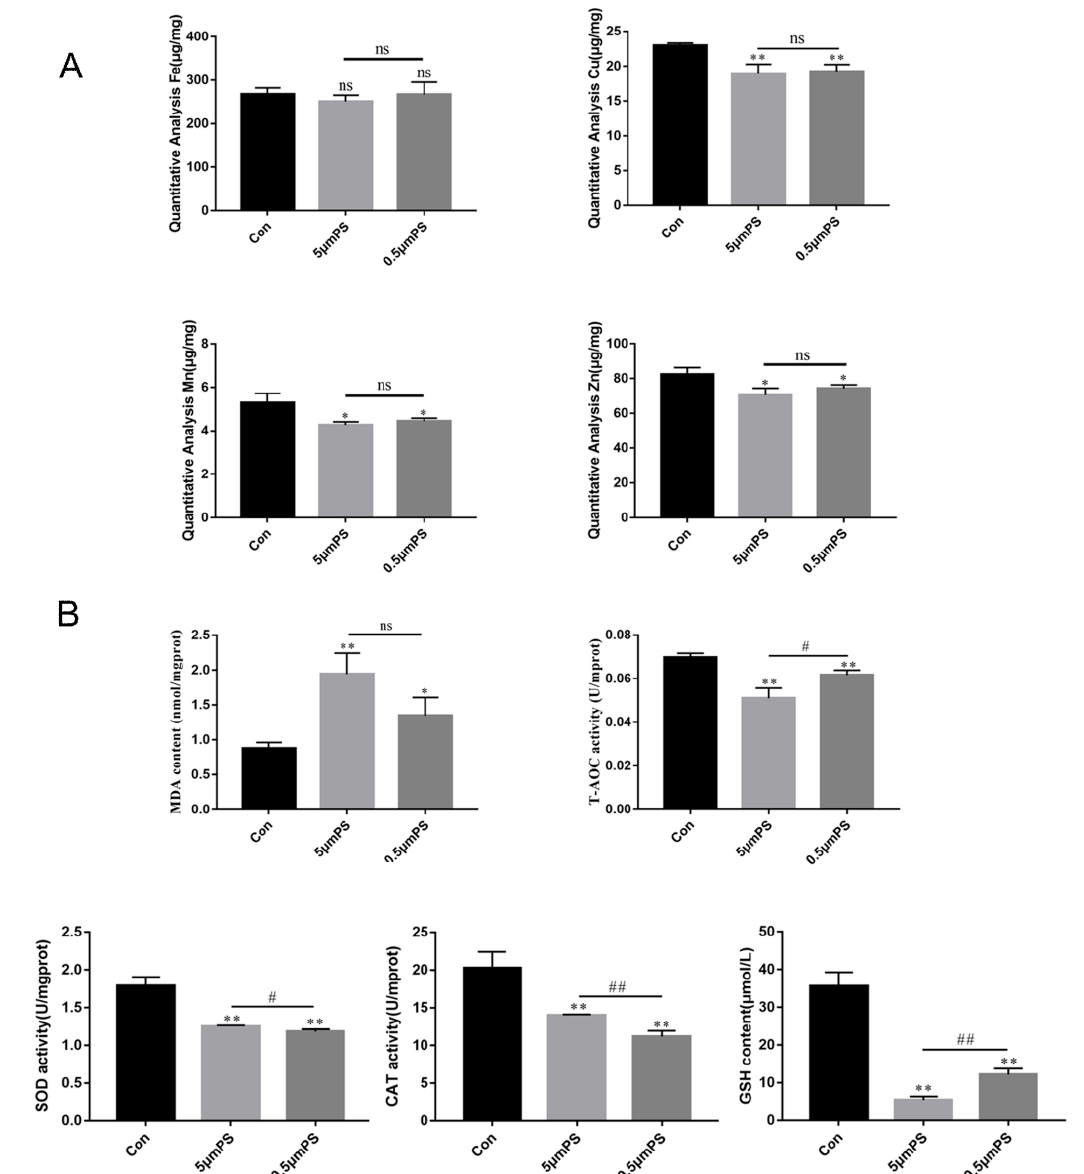
Figure 3. PS-MPs induce oxidative stress in liver. ( A ) Determination of Fe, Cu, Mn, and Zn in mouse liver tissues by AAS. ( B ) Detection of T-AOC, SOD, GSH, CAT activity, and MDA in liver. Results are shown as mean ± SD ( n = 3). Compared with the control group, * p < 0.05, ** p < 0.01. Compared with the 0.5 µ m PS-MPs group, # p < 0.05, ## p < 0.01. ns indicates not statistically significant. AAS—atomic absorption